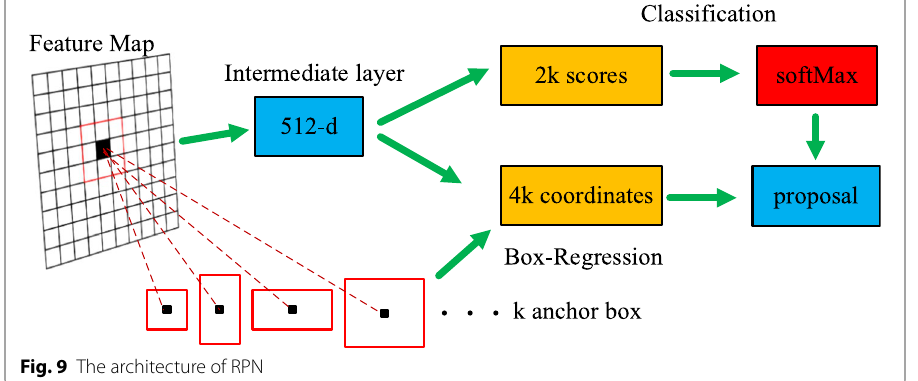
Fig. 9 The architecture of RPN